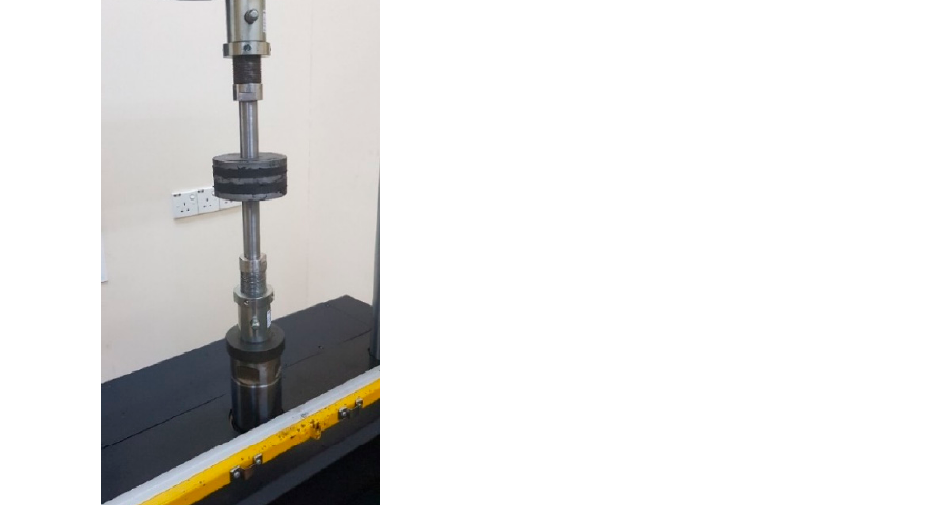
Table 2. Result data for force–displacement under tension and compression.